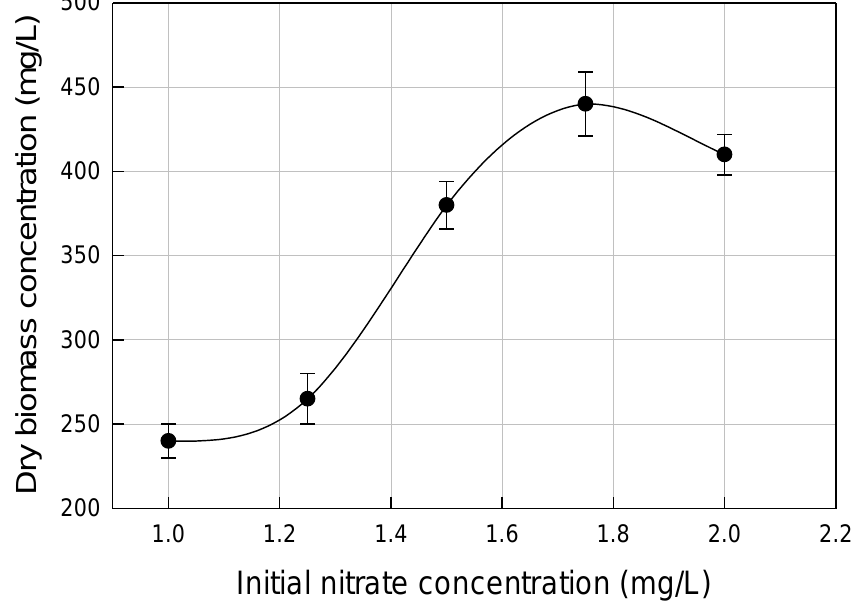
Figure 4. Dry cell mass concentration on day 15 in media with specified initial nitrate (as NaNO 3 ) concentrations. Average values ± standard deviation of five replicates. (Initial phosphate and silicate concentrations were 6.5 mg L − 1 (as NaH 2 PO 4 · H 2 O) and 8.5 mg L − 1 (as Na 2 SiO 3 · 9H 2 O), respectively, in all experiments.).